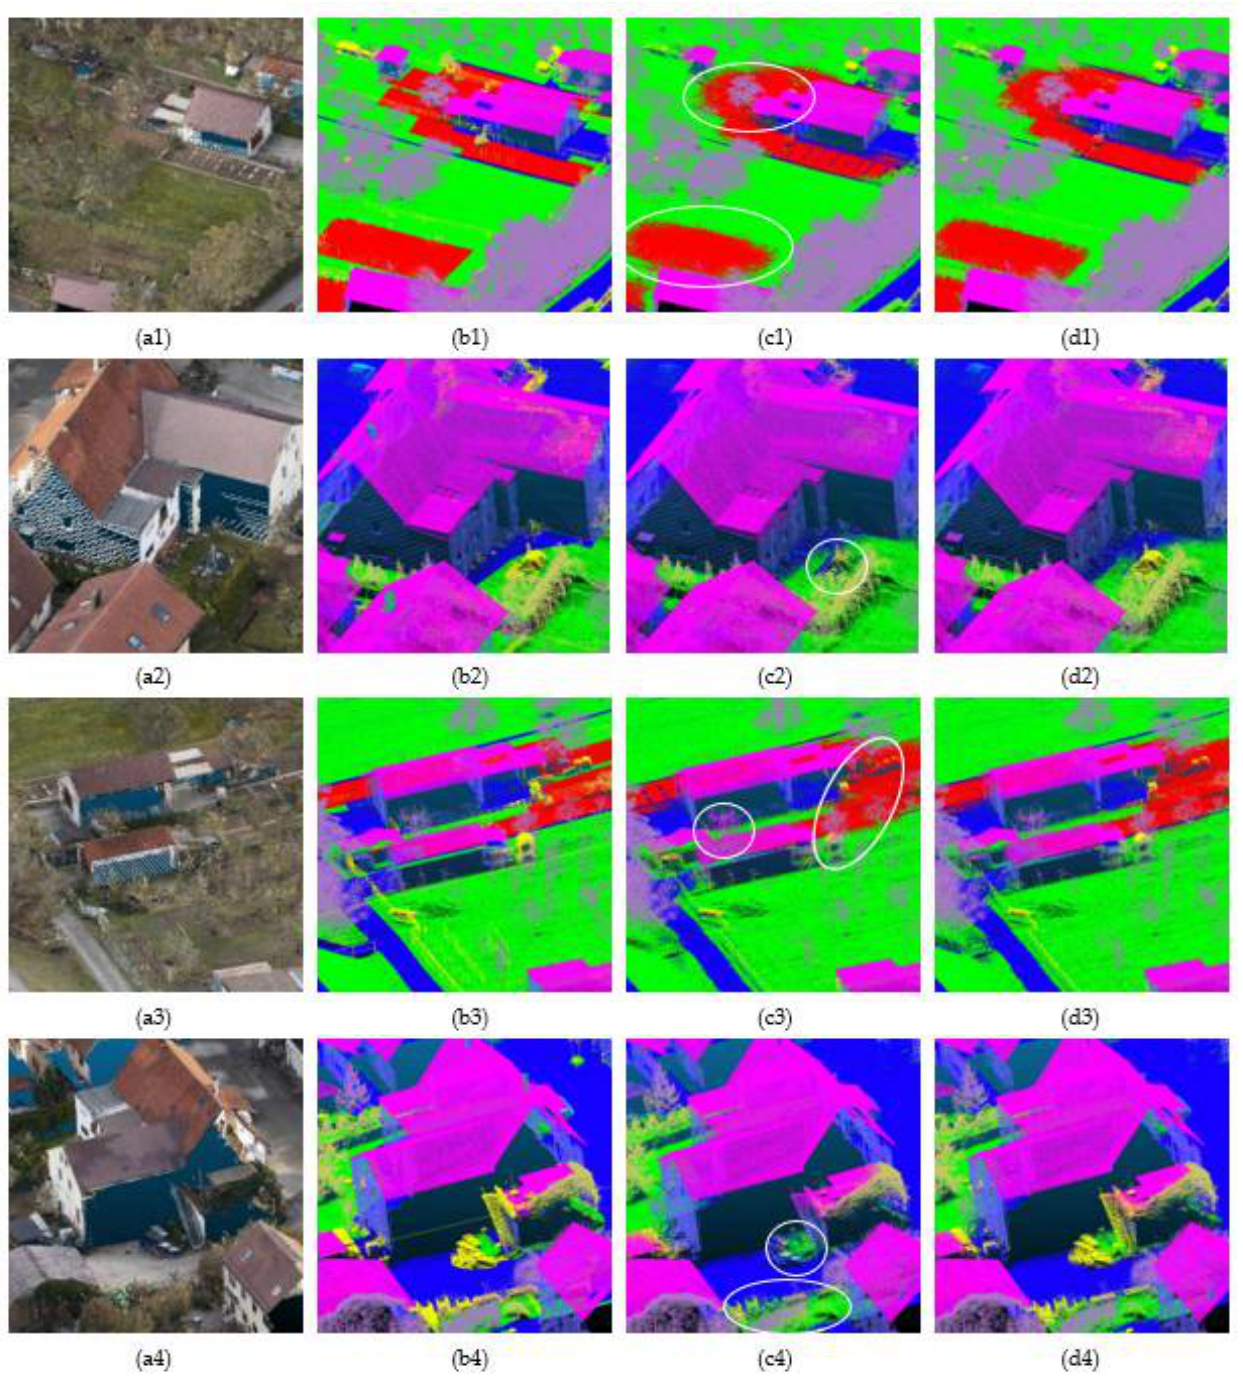
Figure 8. 3D semantic segmentation on the H3D dataset. ( a1 ) Data of Scene 1; ( b1 ) Ground Truth; ( c1 ) PAConv; ( d1 ) PIIE-DSA-net; ( a2 ) Data of Scene 2; ( b2 ) Ground Truth; ( c2 ) PAConv; ( d2 ) PIIE- DSA-net; ( a3 ) Data of Scene 3; ( b3 ) Ground Truth; ( c3 ) PAConv; ( d3 ) PIIE-DSA-net; ( a4 ) Data of Scene 4; ( b4 ) Ground Truth; ( c4 ) PAConv; ( d4 ) PIIE-DSA-net.